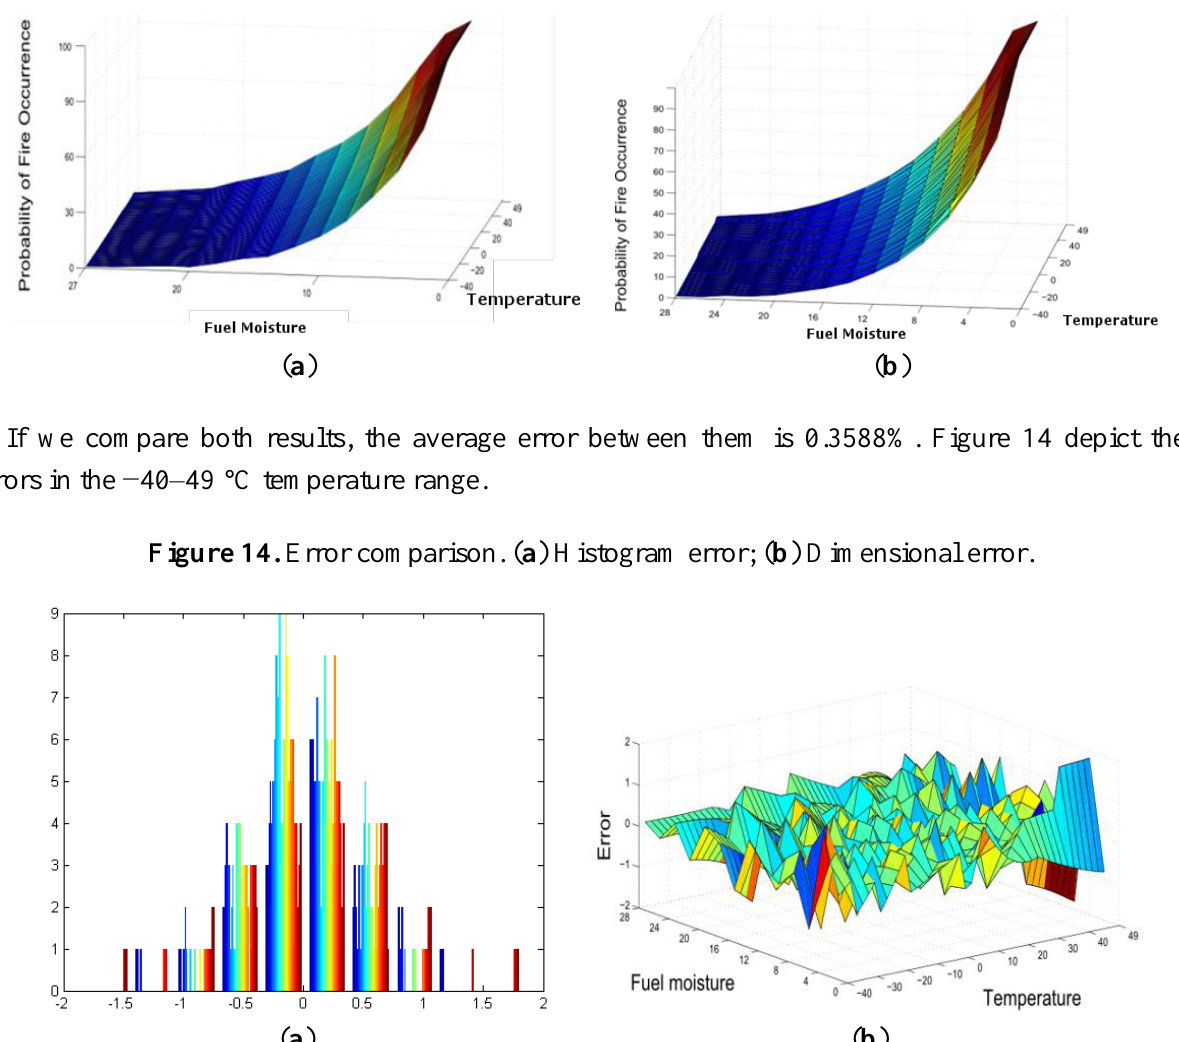
Figure 13. Comparison of the probability of fire. ( a ) SIPIRSI simulator; ( b ) Be-have Plus simulator.